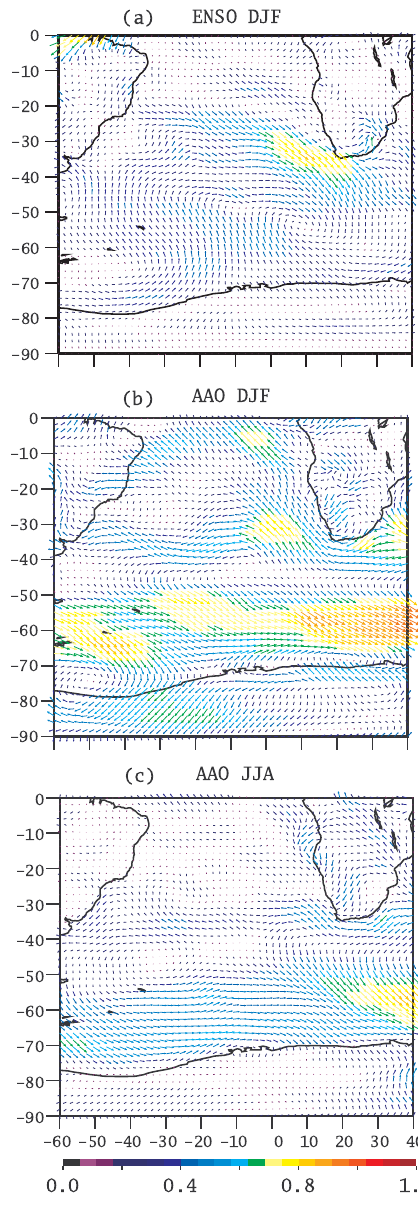
Figure 11. Correlation pattern between the downward wind stress from the NCEP/NCAR reanalysis and the Multivariate ENSO index (MEI) in DJF (a) and the Antarctic Oscillation (AAO) index in DJF (b) and JJA (c) in the period 1950–2010. The zonal and meridional components of the arrows represent the correlation of MEI and ac- cordingly AAO with the zonal and meridional component of the wind stress, respectively. The colours code the square root of the sum of these zonal and meridional correlations